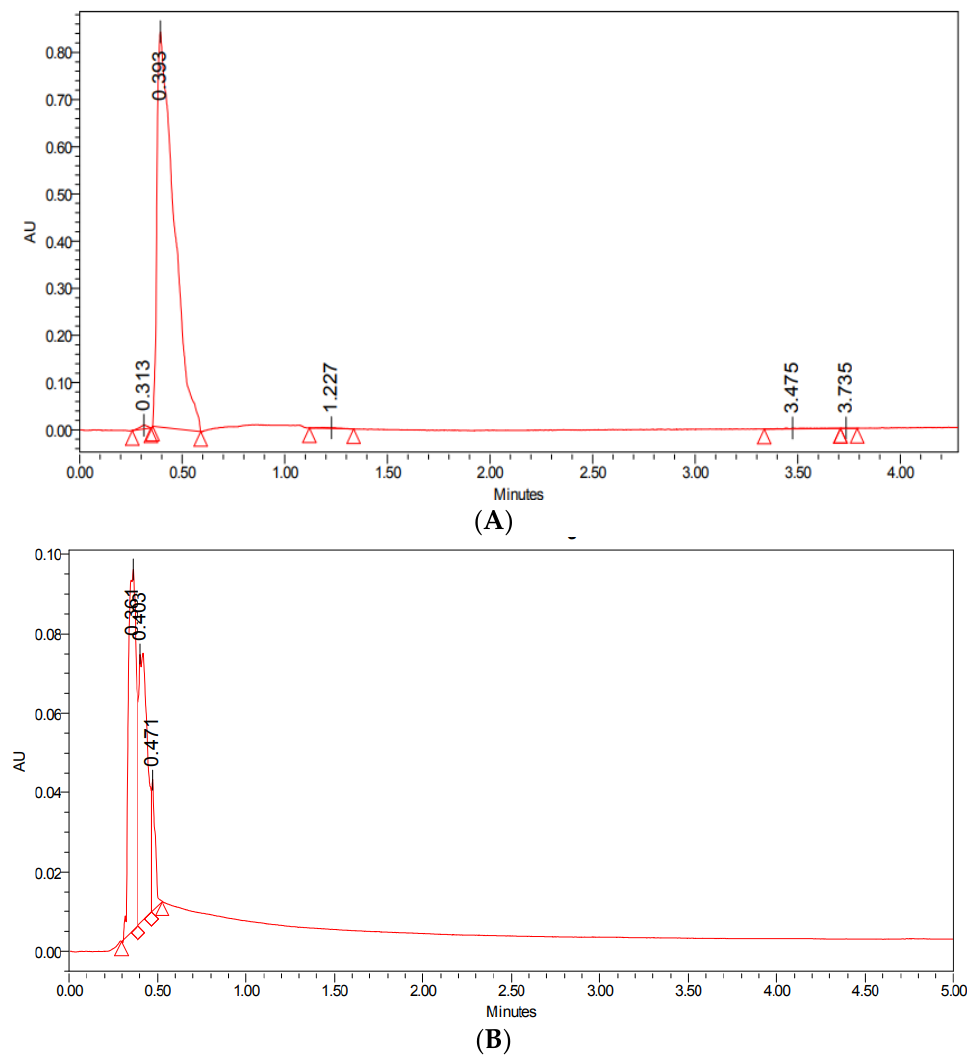
Figure 1. UPLC analysis of ( A ) standard drug paclitaxel, and ( B ) PTX-SeNPs-chit.